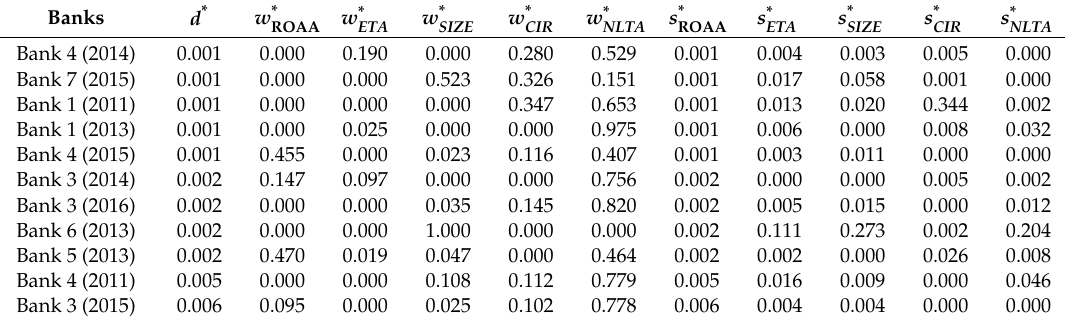
Table 8. Results of value-based DEA (Phase 2) for the first 12 ine ffi cient